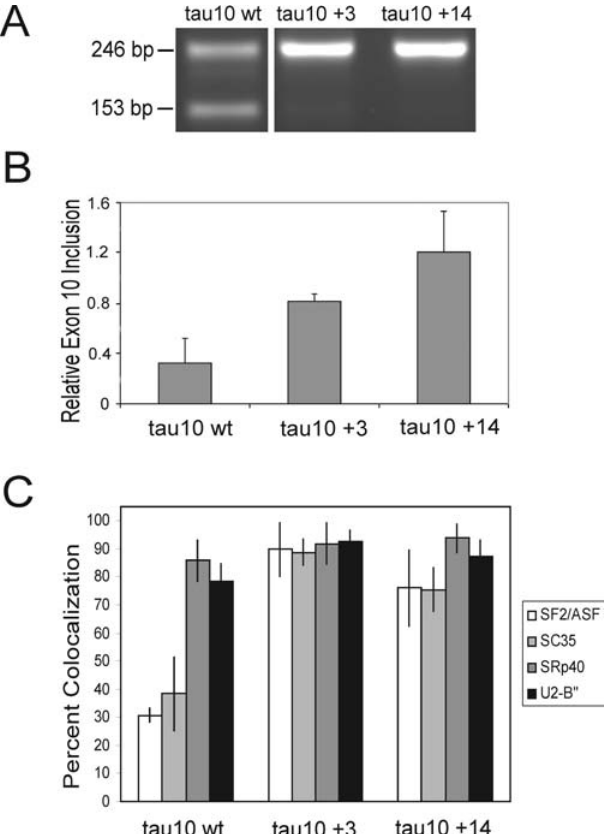
Figure 3. Recruitment of Endogenous Pre-RNA Splicing Factors to Transcription Sites Containing tau Exon 10 mRNA (A) Recruitment of splicing factors to tau transcription sites detected by combined RNA-FISH using a specific probe against tau exon 10 (green) and IF microscopy with specific anti-splicing factor antibodies (red). All associations were confirmed by linescan analysis. Scale bar ¼ 2.5 l m. (B) Quantitation of percentage of cells with colocalization of tau RNA- FISH and splicing factor signals. Values represent averages from at least 100 transcription sites from at least three experiments 6 SEM. Recruitment to the subpopulation of transcription sites containing predominantly tau exon10 mRNA in tau10wt cells was as efficient as recruitment in tau10 (cid:1) 1 cells. DOI: 10.1371/journal.pbio.0030374.g003